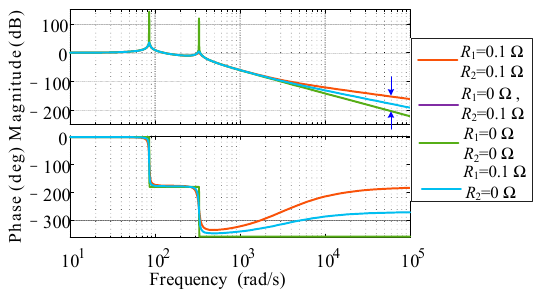
Figure 9. Comparison of voltage transmission characteristics under different filters.